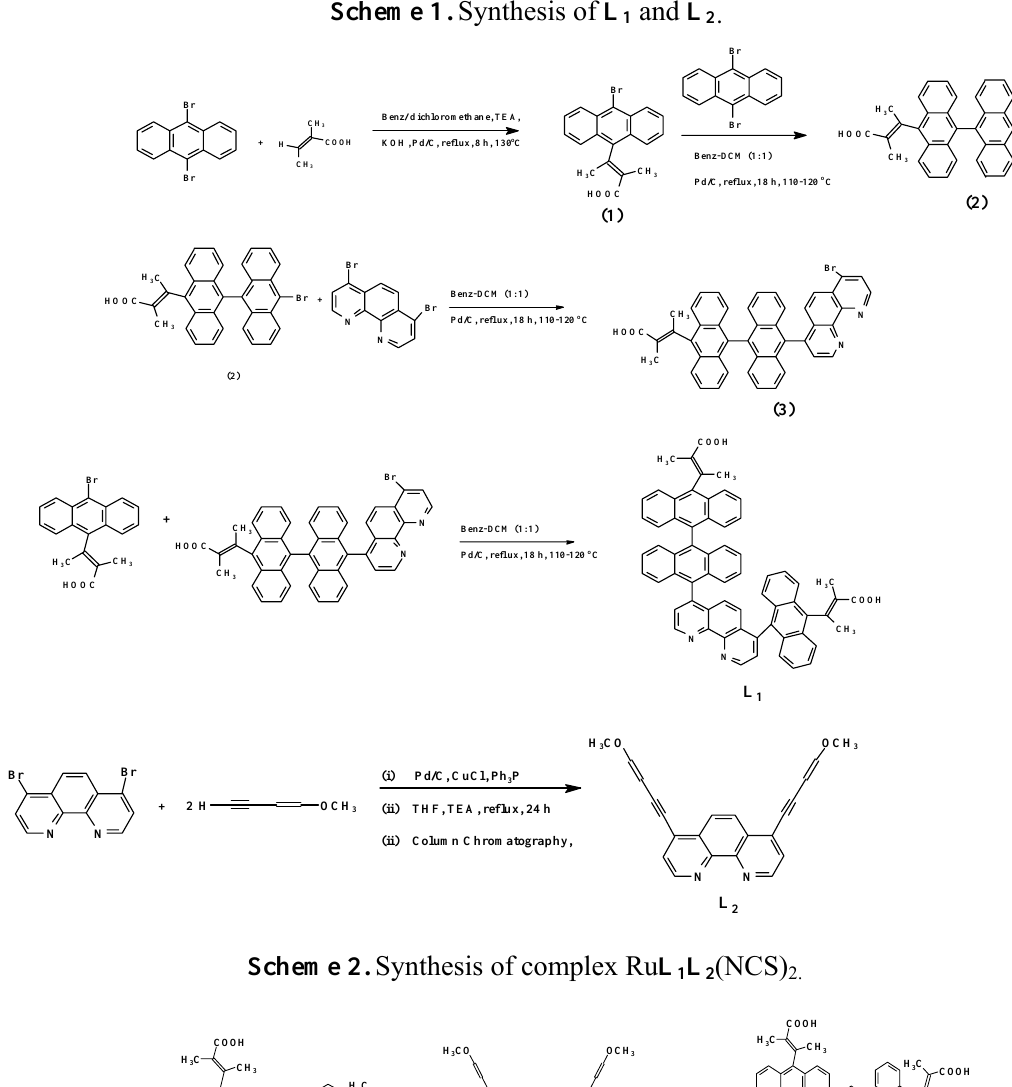
Scheme 1. Synthesis of L